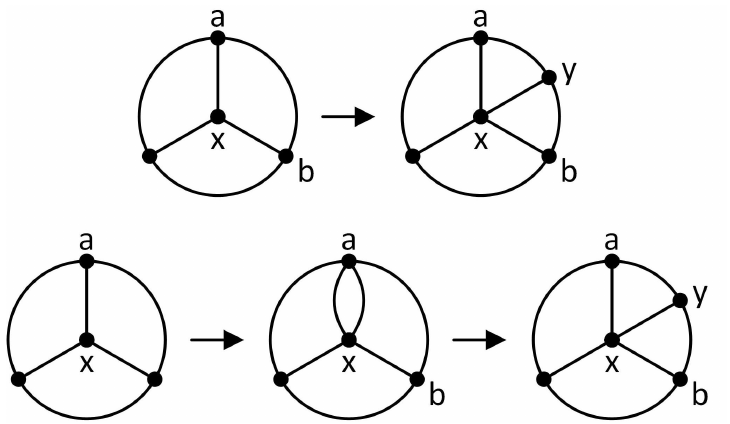
Figure 16. Operation D1 applied to W 3